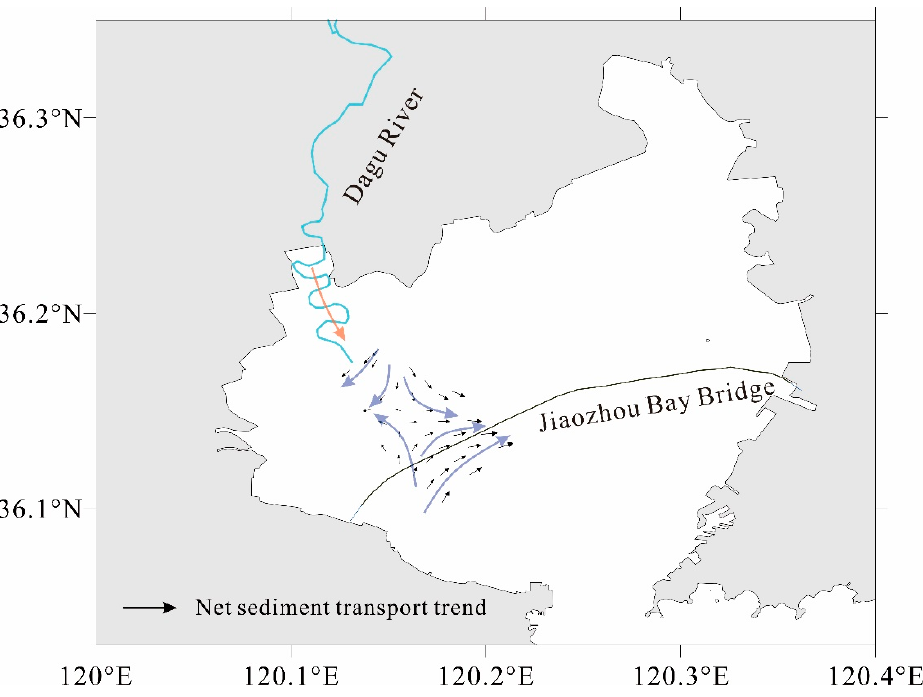
Figure 6. Sediment transport trend in the estuary. The red arrow represents the runoff direction of the Dagu River, and the blue arrow represents the possible current direction of the sea.